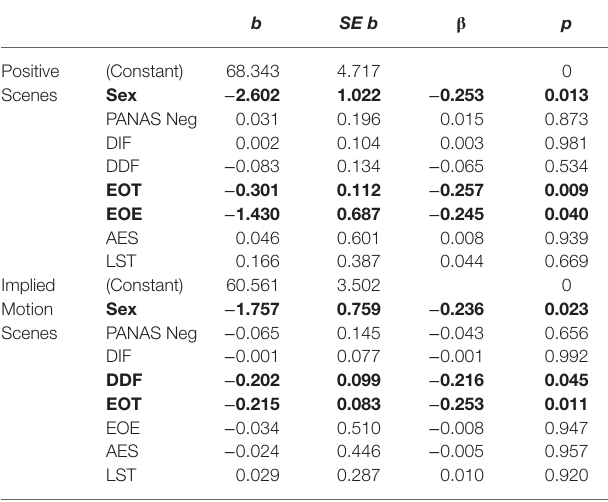
TABLE 2 | Linear models predicting accuracy in judgments of positive and implied motion (IM)